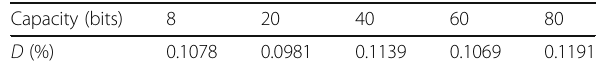
Table 1 Capacity vs.